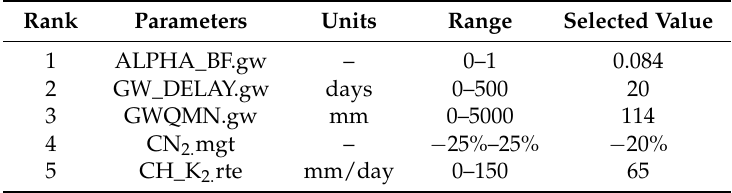
Table 3. Sensitivity analysis of the parameters and values selected for